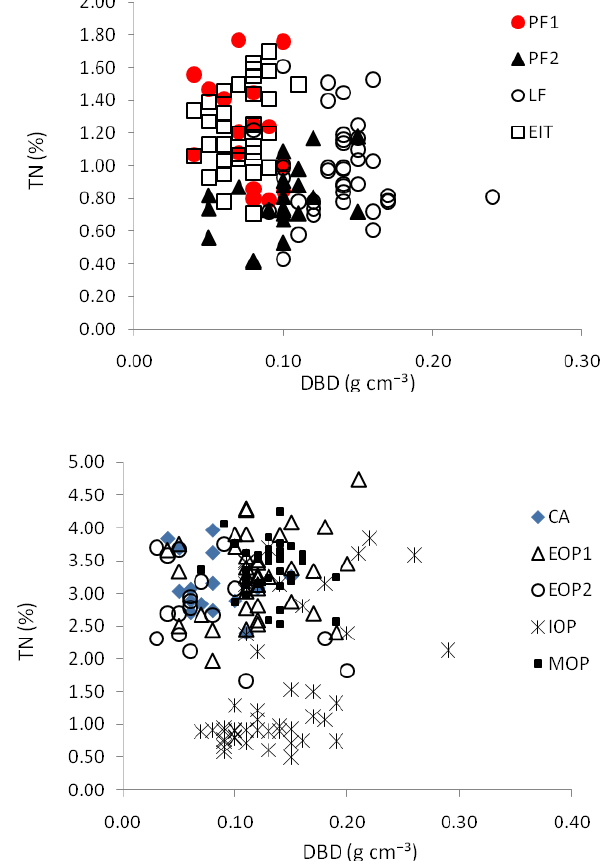
Fig. 4. Scatter plots DBD vs. TN according to Land Use Figure 4. Scatter plots DBD vs TN according to Land Use Groups Groups (PF1 = coastal peat forest; PF2 = inland peat forest; (PF1= coastal peat forest; PF2= inland peat forest; LF = logged over peat forest; EIT = LF = logged over peat forest; EIT = industrial timber plantation; industrial timber plantation; CA= community agriculture; EOP1= Early Oil Palm (< 5 yrs) in CA = community agriculture; EOP1 = Early Oil Palm ( < 5yrs) in coastal peat; EOP2 = Early Oil Palm ( < 5yrs) in inland peat; coastal peat; EOP2 = Early Oil Palm (<5 yrs) in inland peat; IOP = Intermiediate Oil Palm (5-10 IOP = Intermiediate Oil Palm (5–10yrs); MOP = Mature Oil Palm yrs); MOP = Mature Oil Palm (15-20 yrs)